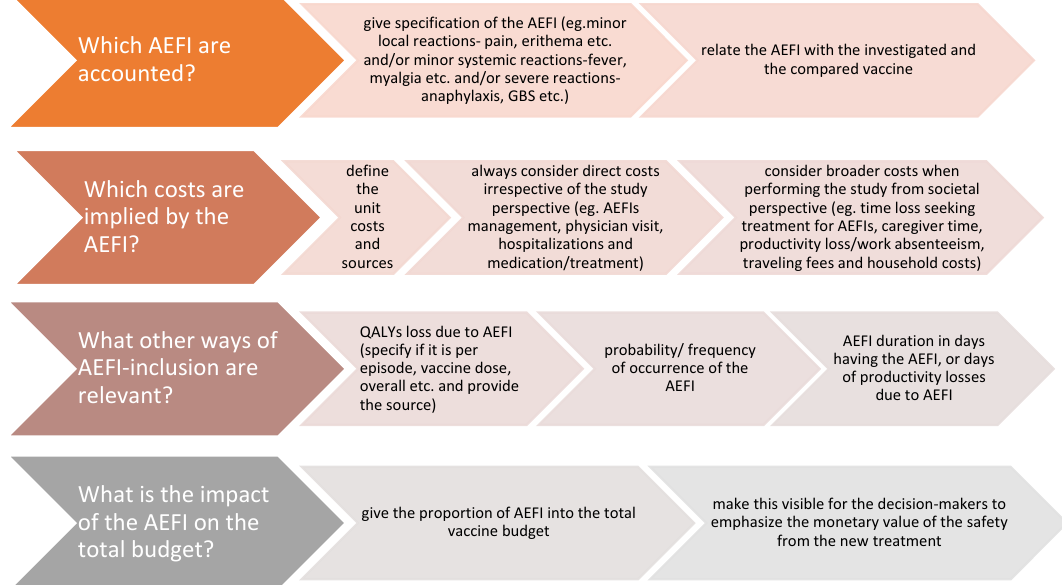
Figure 2. A four-step structure for inclusion of AEFI within economic evaluation on seasonal influenza vaccines. AEFI — adverse event following immunization; QALYs — quality-adjusted life years.